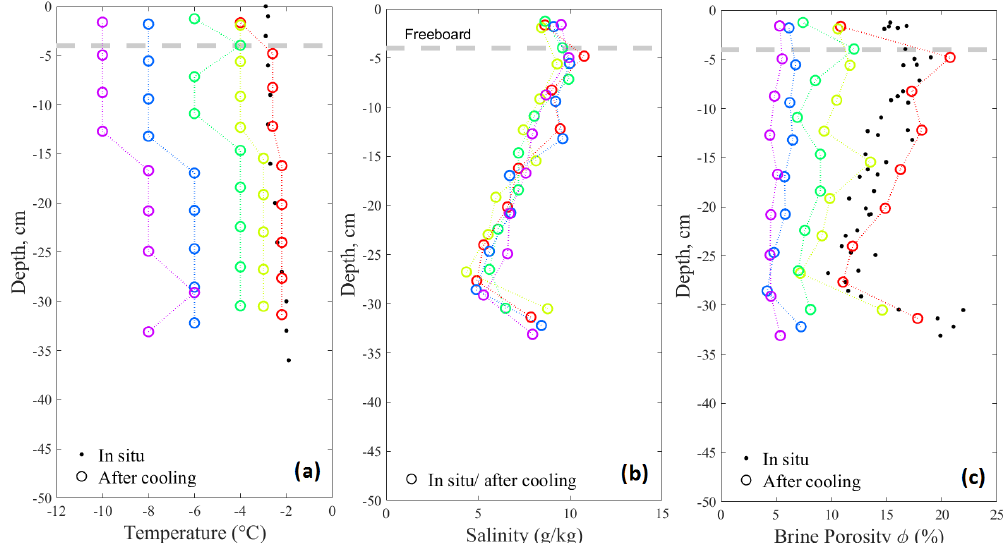
Figure 3. Properties of 5 + 1 sea ice cores obtained on 16 March 2011 in Advent Bay, Svalbard. (a) In situ ice temperature shown as black dots, five lowered centrifugation temperatures as coloured circles. (b) Bulk salinity obtained from centrifuged brine and melted residual ice in colours. (c) Brine porosity φ based on thermodynamic equilibrium shown. Black dots show in situ values, while coloured circles give the brine porosity for the lowered centrifugation temperatures.